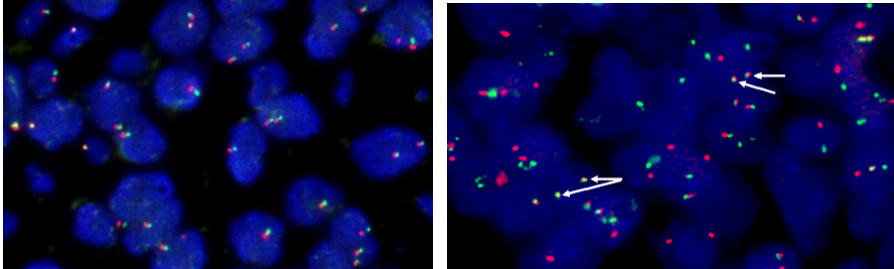
Figure 3. FISH interpretation criteria: (From Abbott Molecular, Vysis probes) (I) Count 50 tumor cells: If the number of positive cells was ≥ 50% (25), the patient was judged to have ALK rearrangements ( On the right ). If the number of positive cells was less than 10% (5), the patient was judged to have no ALK recombination ( On the left ); (II) If the positive cells were ≥ 10% (5) and <50% (25), another 50 tumor cells were counted, and then the 100 tumor cells were counted together. If the number of positive cells is ≥ 15%, the patient is judged to have ALK recombination. If the number of positive cells was less than 15%, the patient was judged to have no ALK recombination. Note: The positive cells were the cells with orange and green signal separation or orange signal alone.